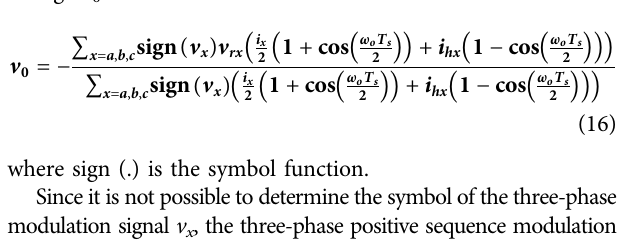
Frontiers in Energy Research |